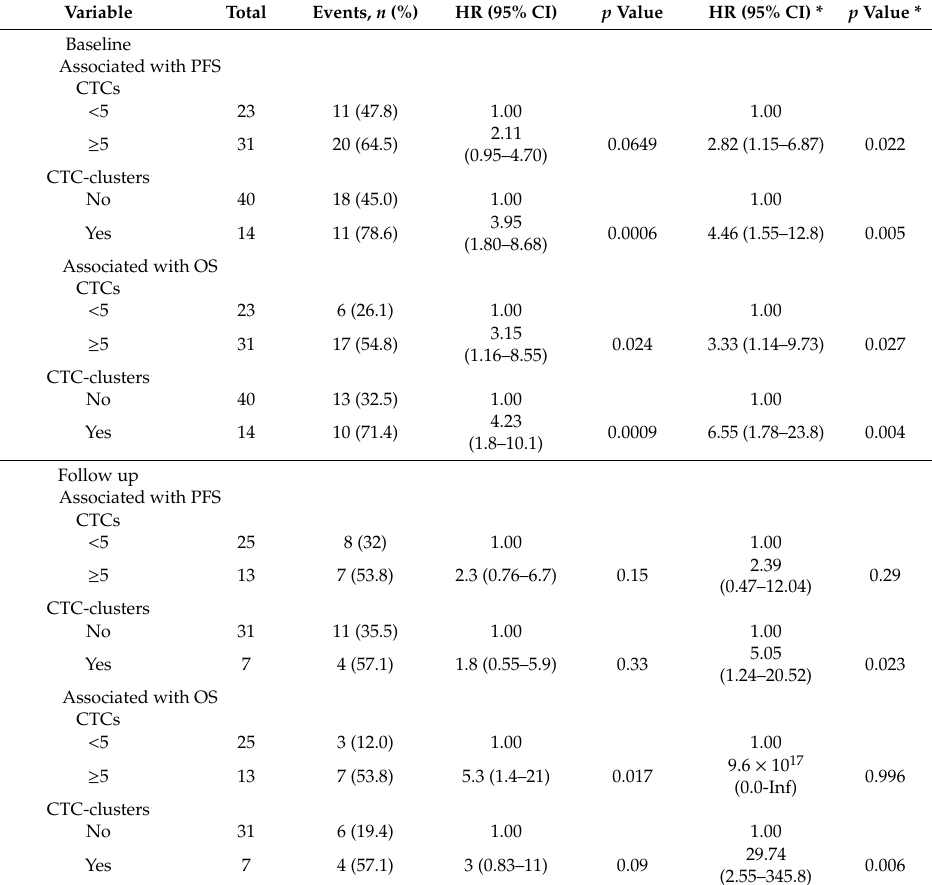
Table 2. Associations between CTCs and CTC-clusters and PFS and OS of MBC